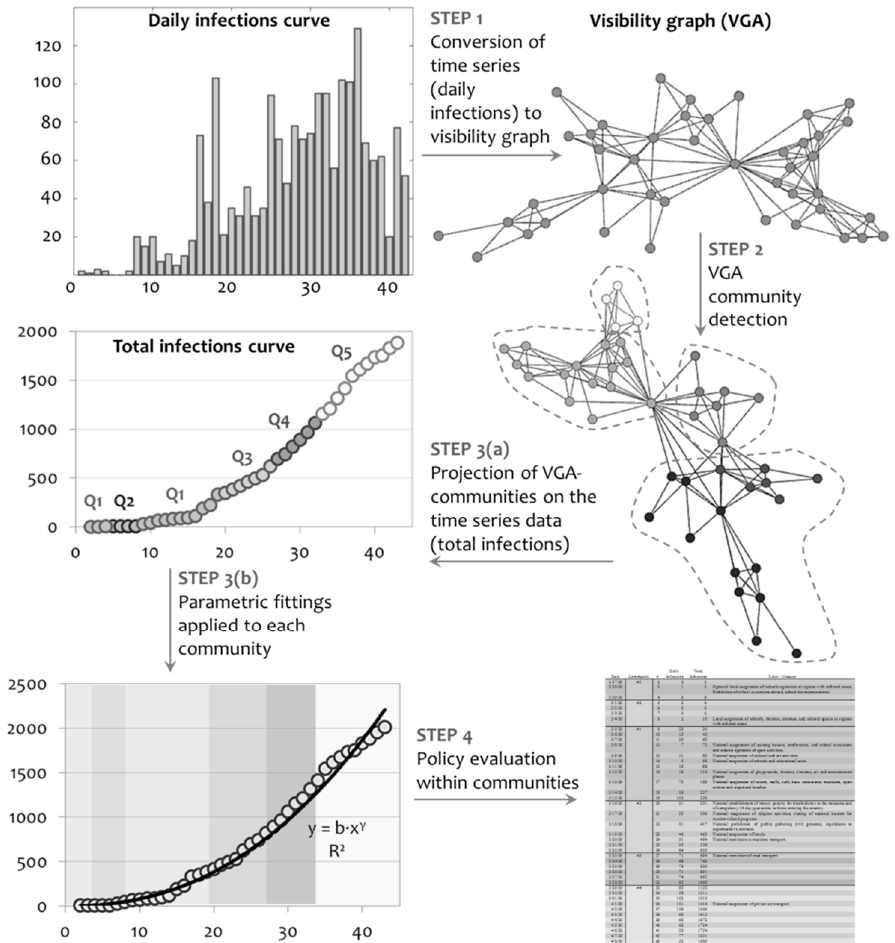
Figure 1. The methodological framework of the study.